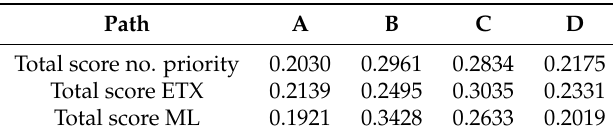
Table 2. Path score for different priority